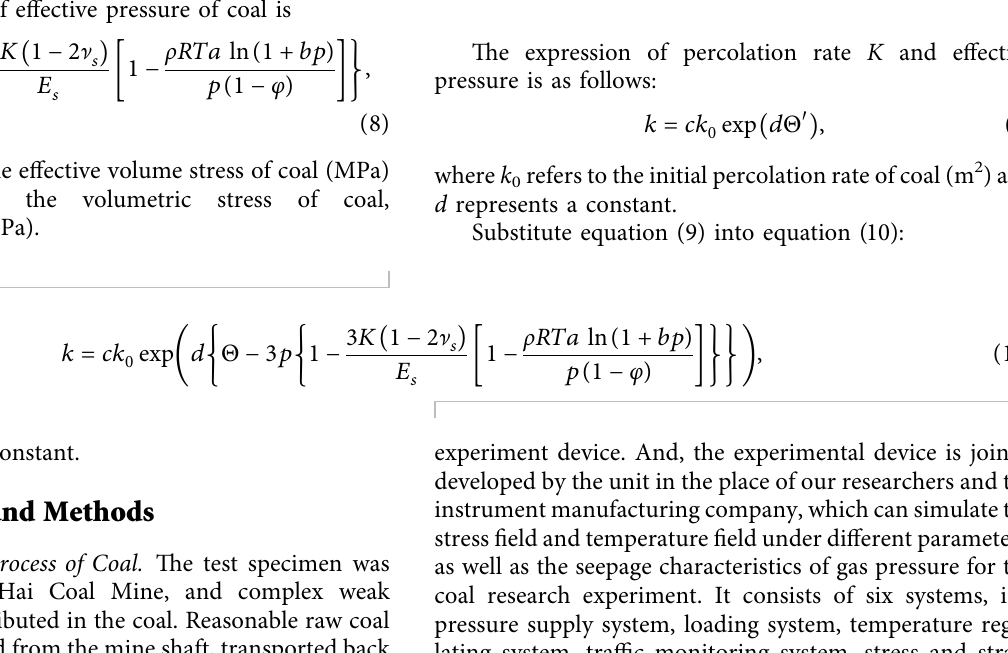
Figure 1: Specimens of raw